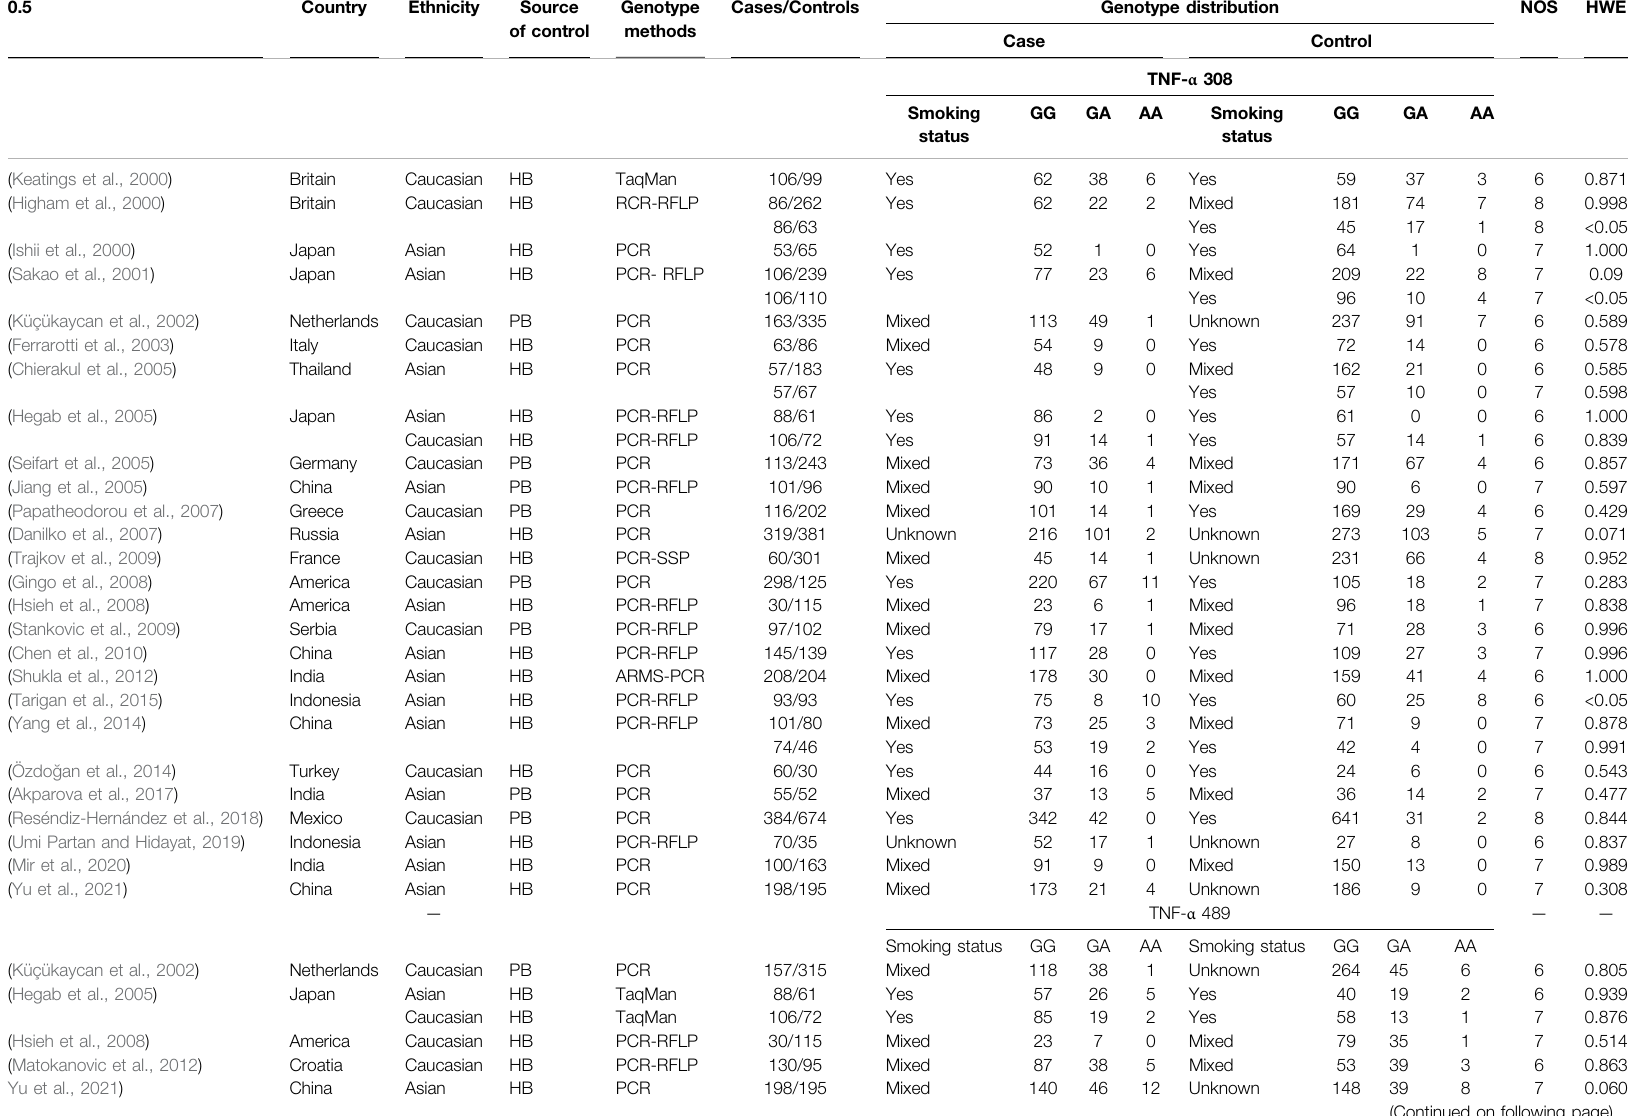
TABLE 1 | Main characters of studies included in this